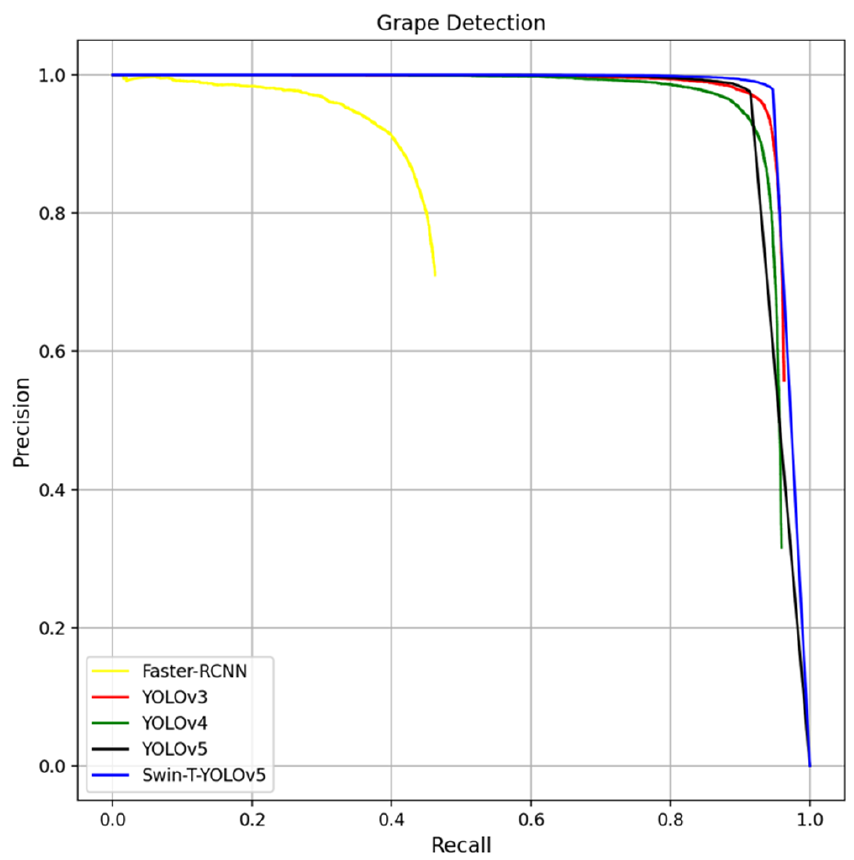
Table 4. Comparison of training and validation results for Faster R-CNN, YOLOv3, YOLOv4, YOLOv5, and Swin-transformer-YOLOv5 (Swin-T-YOLOv5).